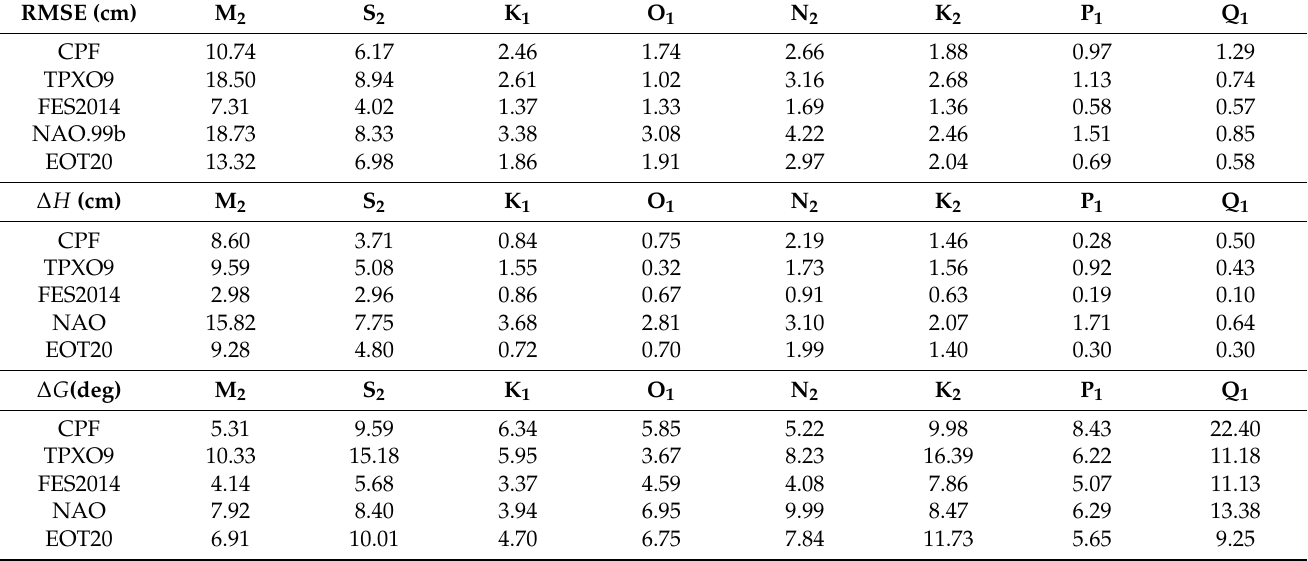
Table 3. The RMSEs and MAEs of the harmonic constants of the results calculated by the CPF method, the TPXO9, FES2014, NAO.99b and the EOT20 models for the eight major constituents, compared with the tidal gauges